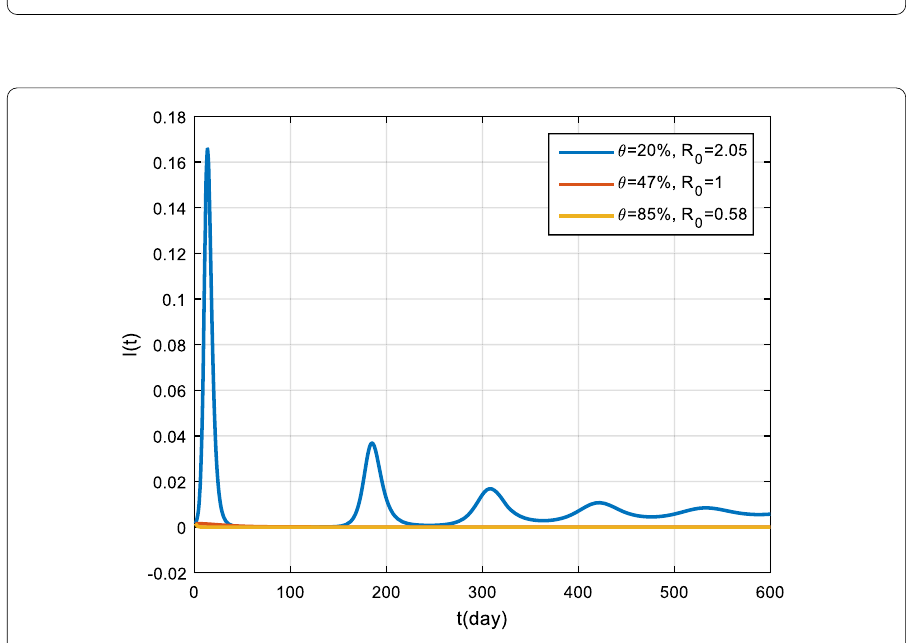
Figure 9 Variation in the number of infected population for different values of θ